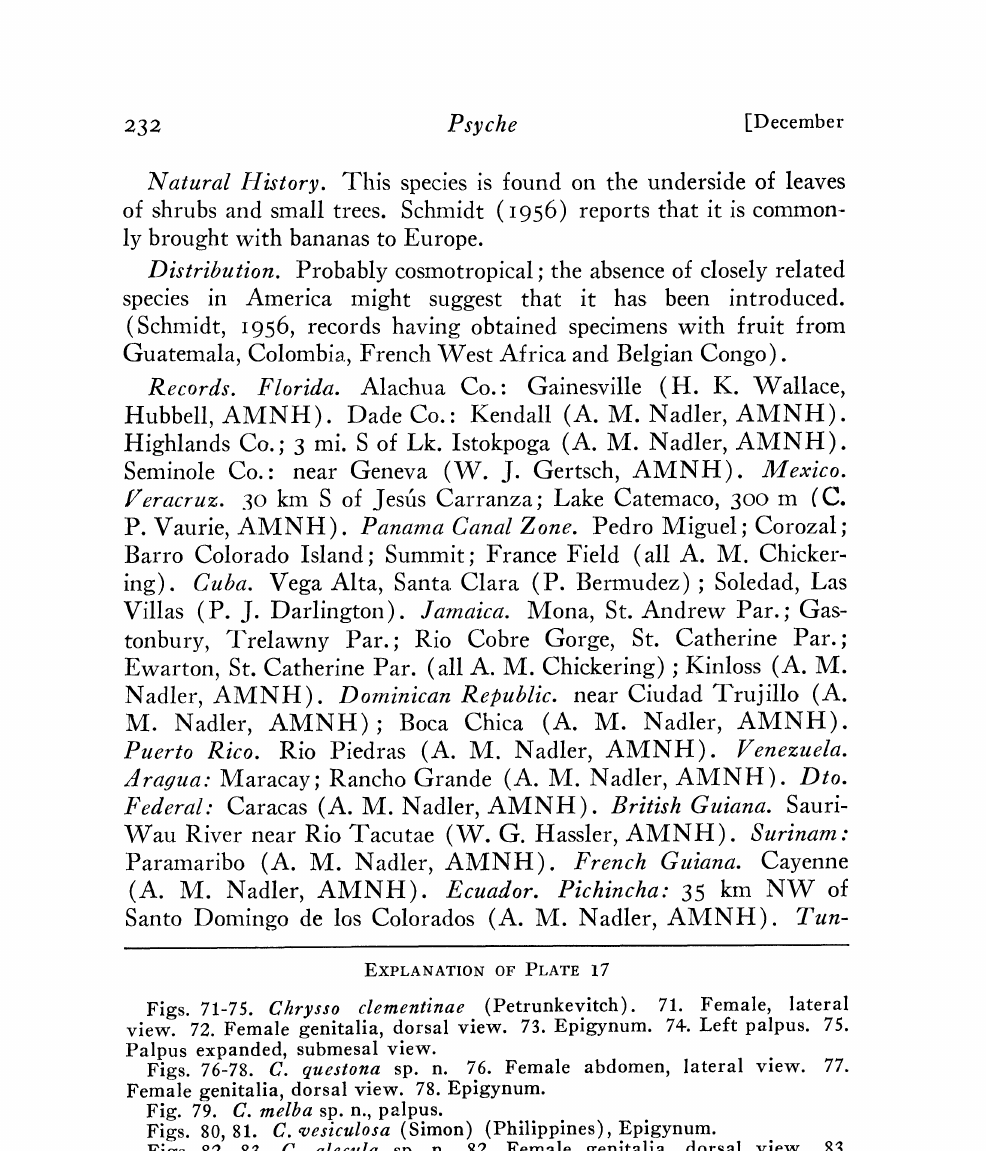
Figs. 71-75. Chrysso clementinae (Petrunkevitch). 71. Female, lateral view. 72. Female genitalia, dorsal view. 73. Epigynum. 74. Left palpus. 75. Palpus expanded, submesal view. Figs. 76-78. C. questona sp. n. 76. Female abdomen, lateral view. 77. Female genitalia, dorsal view. 78. Epigynum. Fig. 79. G. melba sp. n., palpus. Figs. 80, 81. C. esiculosa (Simon) (Philippines), Epigynum. Figs. 82, 83. C. alecula sp. n. 82. Female genitalia, dorsal view. 83. Epigynum. Figs. 84, 85. C,. arima sp. n. 84. Female genitalia, dorsal view. 85. Epigy- num. Figs. 86-90. G. silva sp. n. 86. Female. 87. Female genitalia, dorsal view. 88. Epigynum. 89. Palpus. 90. Palpus expanded, subventral view. Figs. 91-95. C. olcanensis sp. n. 91. Female. 92. Female genitalia, dorsal view. 93. Epigynum. 94. Palpus expanded, cymbium removed, dorsal view. 95.